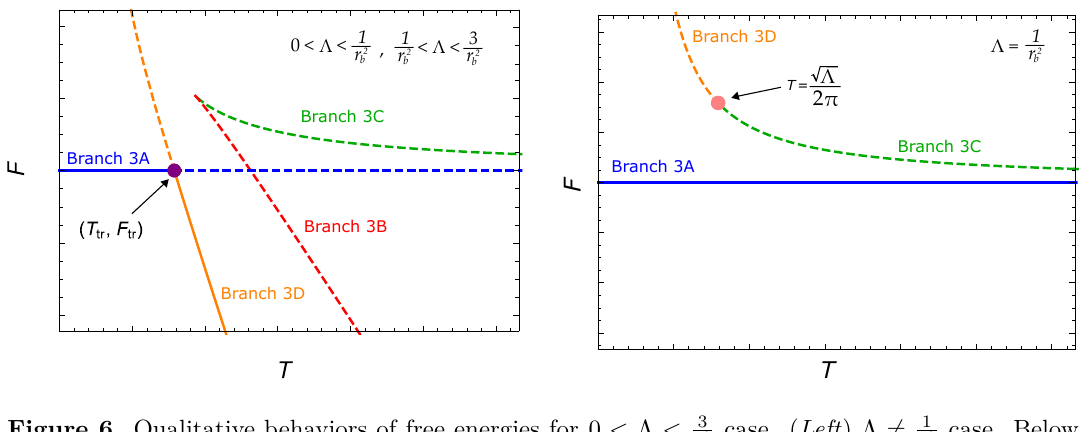
case. ( Left ) Λ 6 = 1 case. Below r 2 r 2 b b case. Branch 3A r 2 b